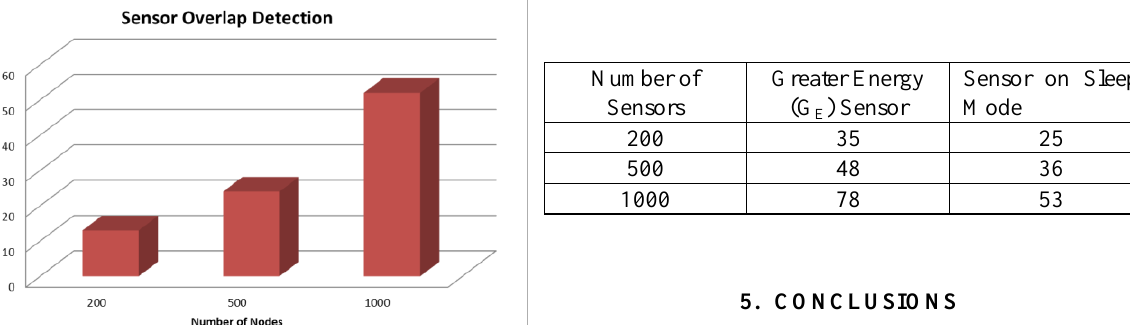
Table 1. Number of sensor that are set to sleep